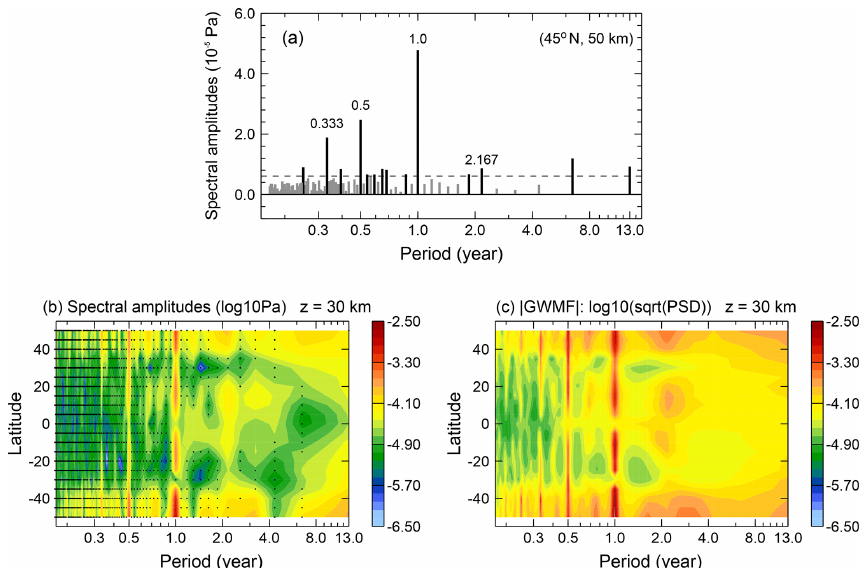
Figure 1. Example of a FFT spectrum of absolute GWMF performed at the latitude 45 ◦ N and altitude 50km (a) , and latitude dependence of the spectra at 30km altitude for the latitude range 50 ◦ S–50 ◦ N (b) . For comparison, also the MEM spectra at 30km altitude are displayed for the latitude range 50 ◦ S–50 ◦ N (c) . The significance level of 1.3 times the average spectral amplitude is shown as a horizontal dashed line in (a) . Black dots in (b) indicate spectral amplitudes below the significance level of 1.3 times the average spectral